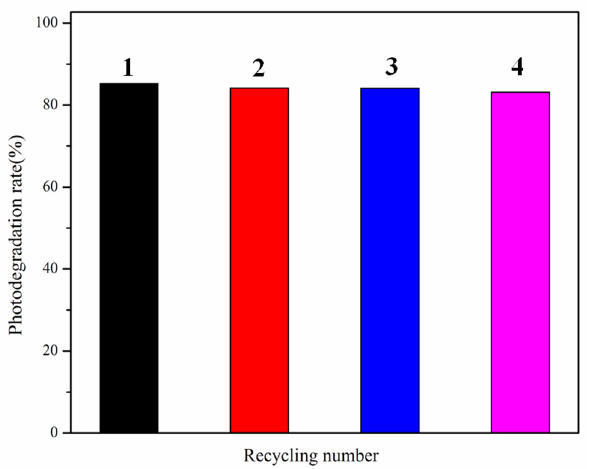
Figure 6. Recycling tests for the photodegradation of RhB over the Di/Ur-4:5 composite under visible light.